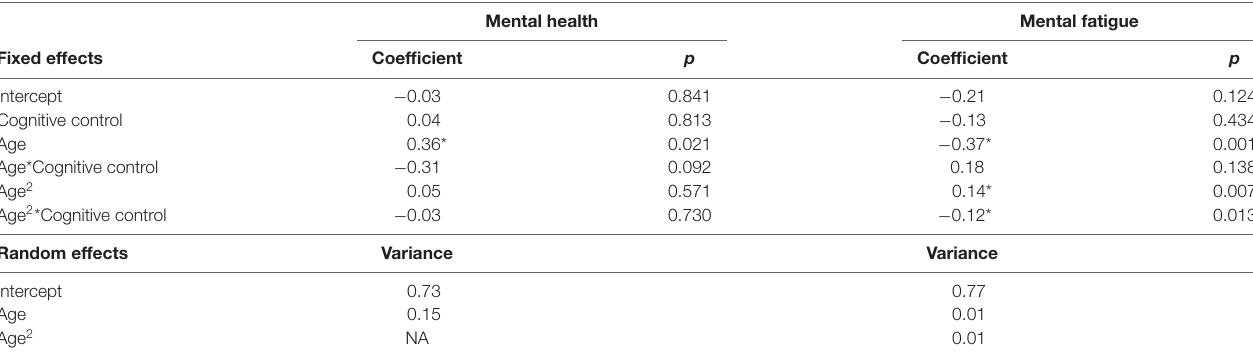
TABLE 2 | Results from multilevel growth curve analyses on two aspects of subjective well-being.